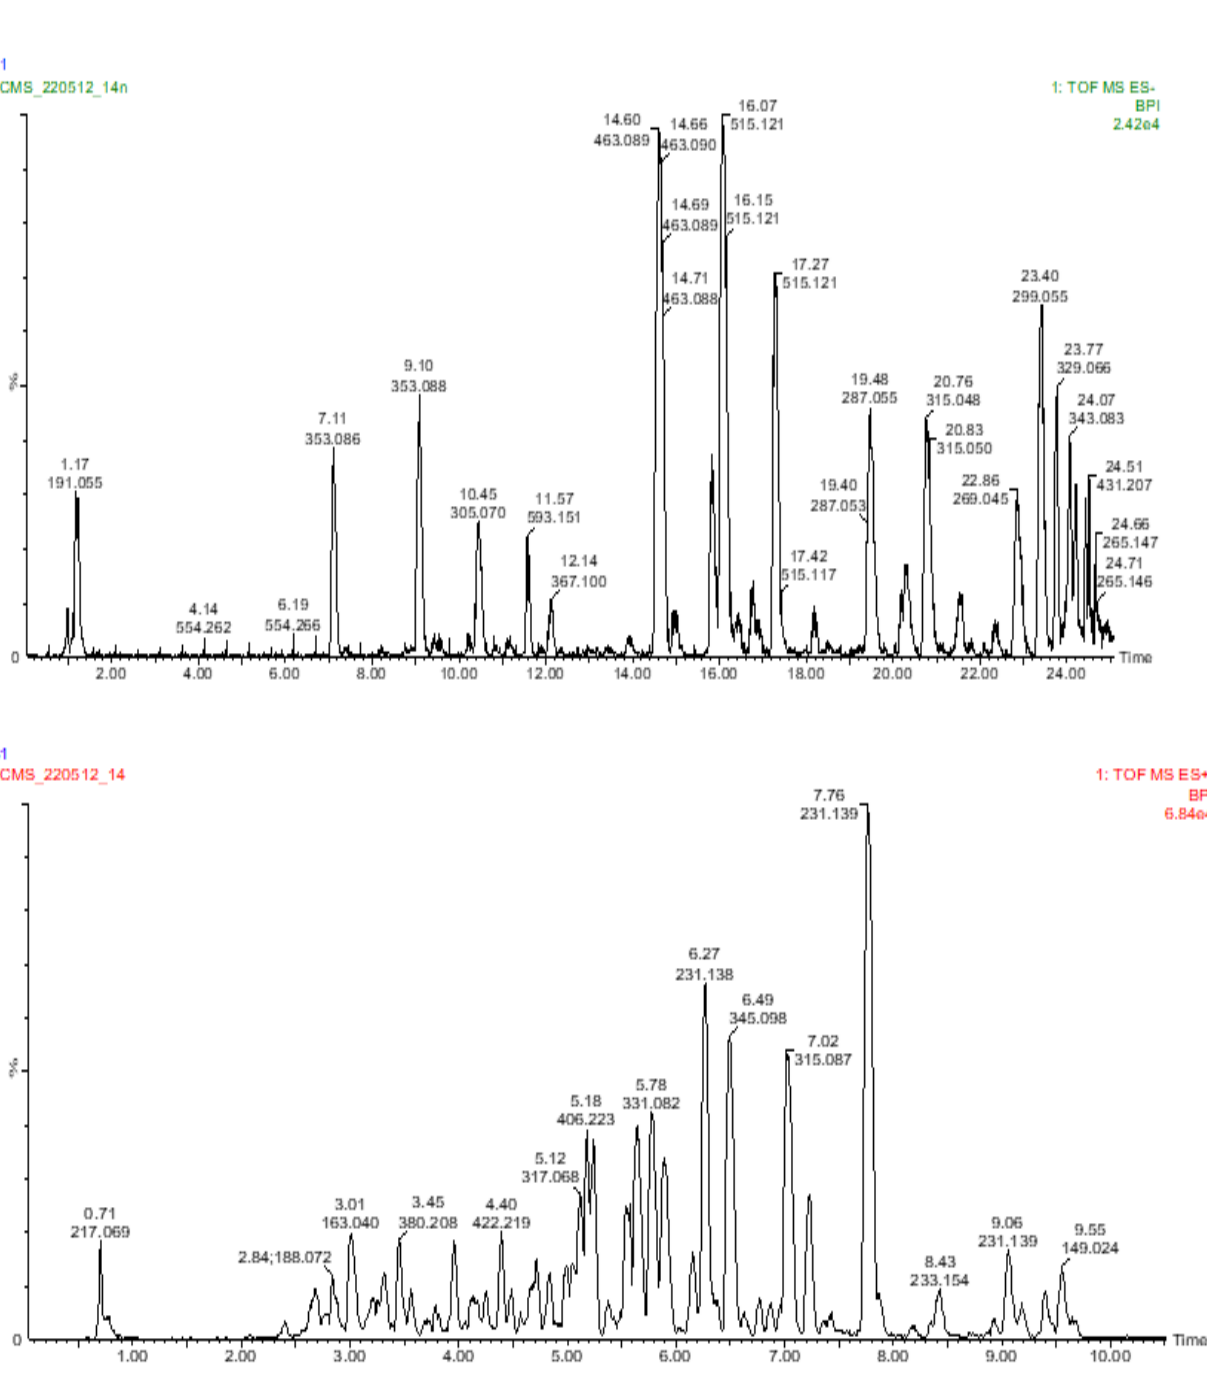
Figure 1. UHPLC-ESI-MS base peak chromatogram for the methanol extract of E. africanus ’s negative and positive ion modes.